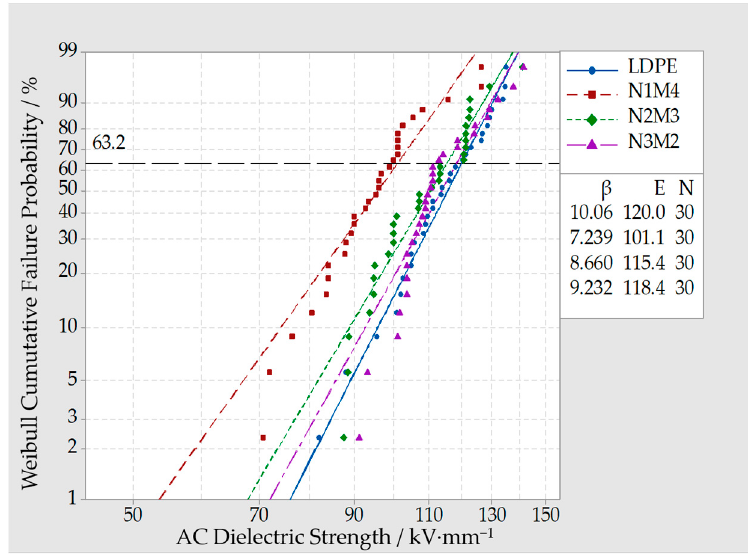
Figure 7. Weibull distribution curve of different Micro-Nano-ZnO/LDPE composites.